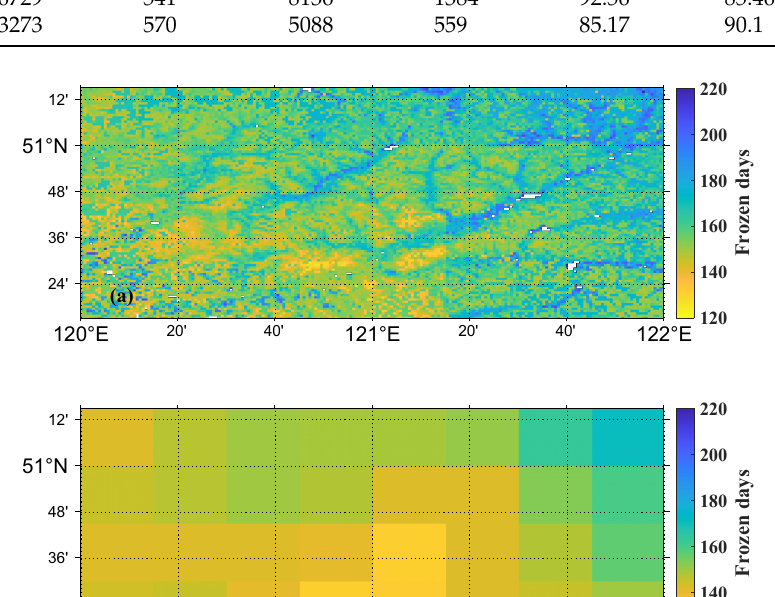
Figure 22. Comparisons of thawed ( a ), frozen ( b ), and total ( c ) accuracies between F/T AMSR2 and F/T new at the site level.